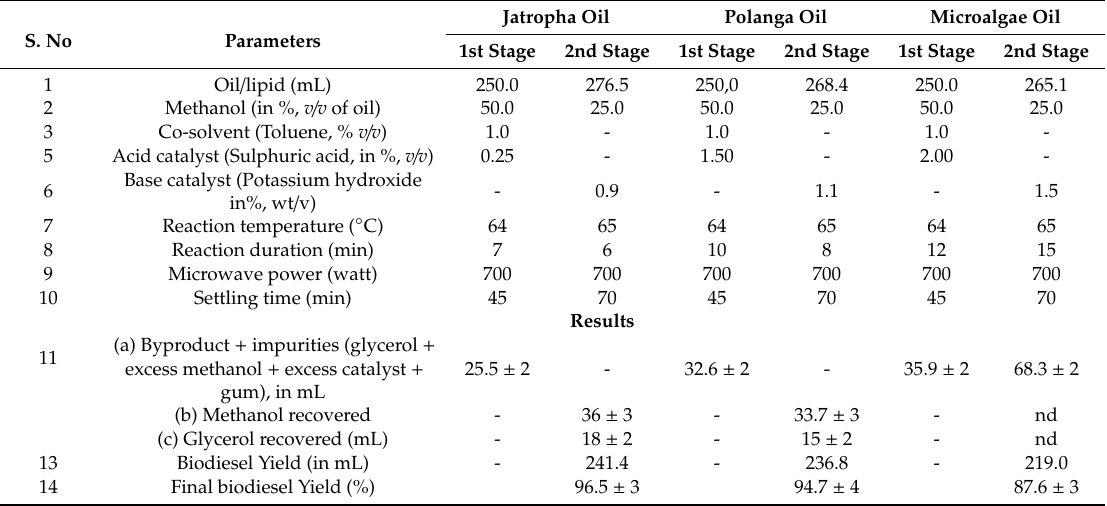
Table 1. Production of microalgae, jatropha, and polanga